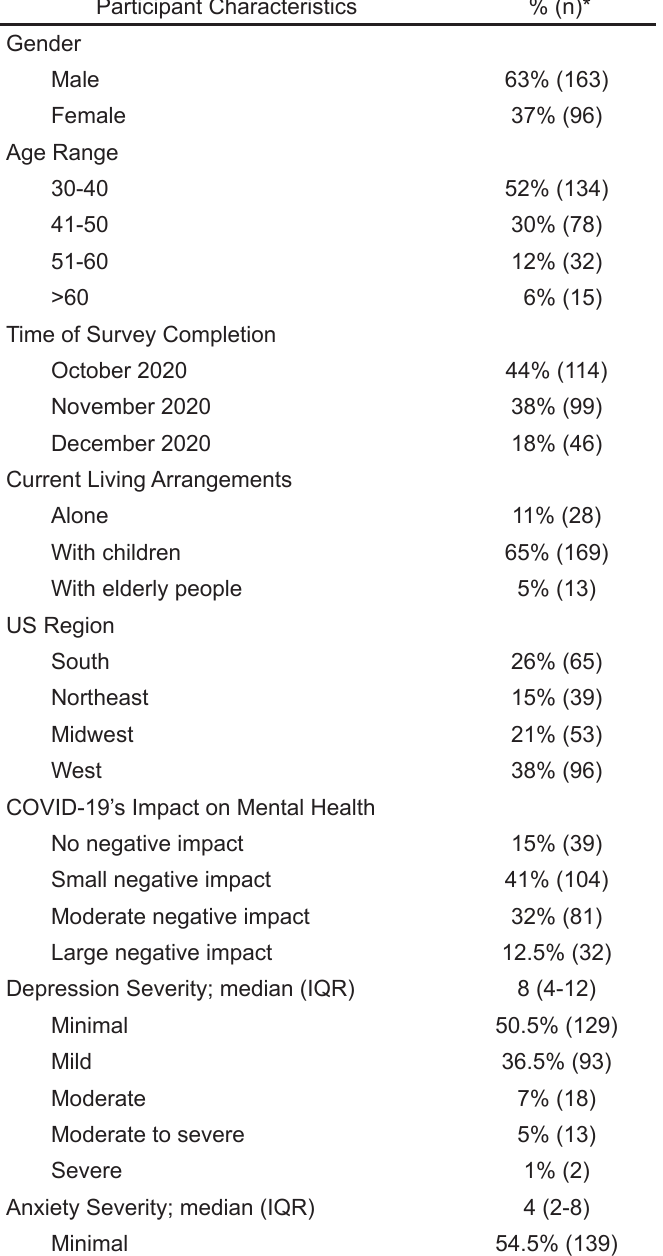
Table 1 . Characteristics of the emergency physicians who partici- pated in COVID-19 survey.